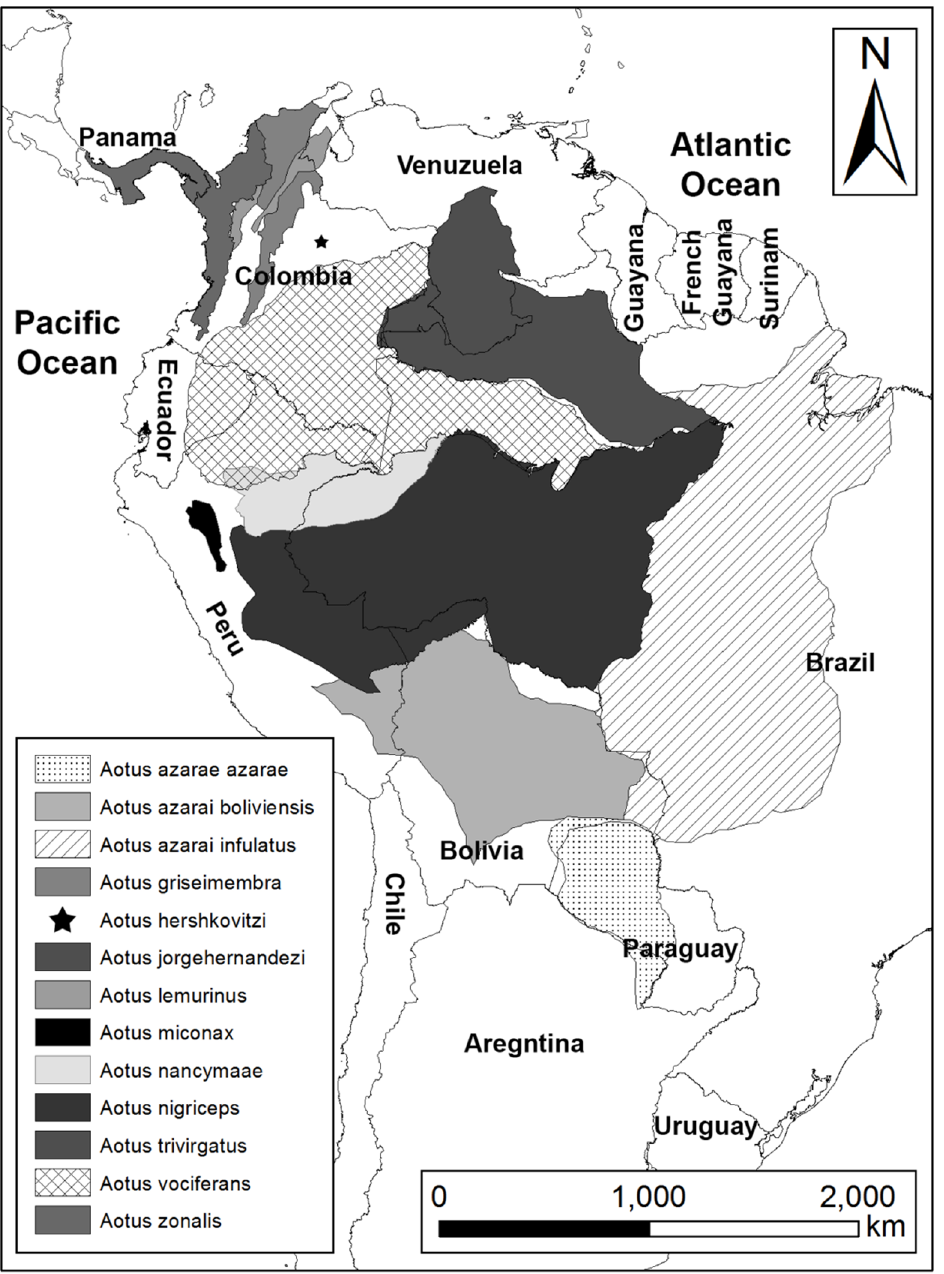
Figure 3. Predicted distributions of Aotus taxa based on Rowe & Myers